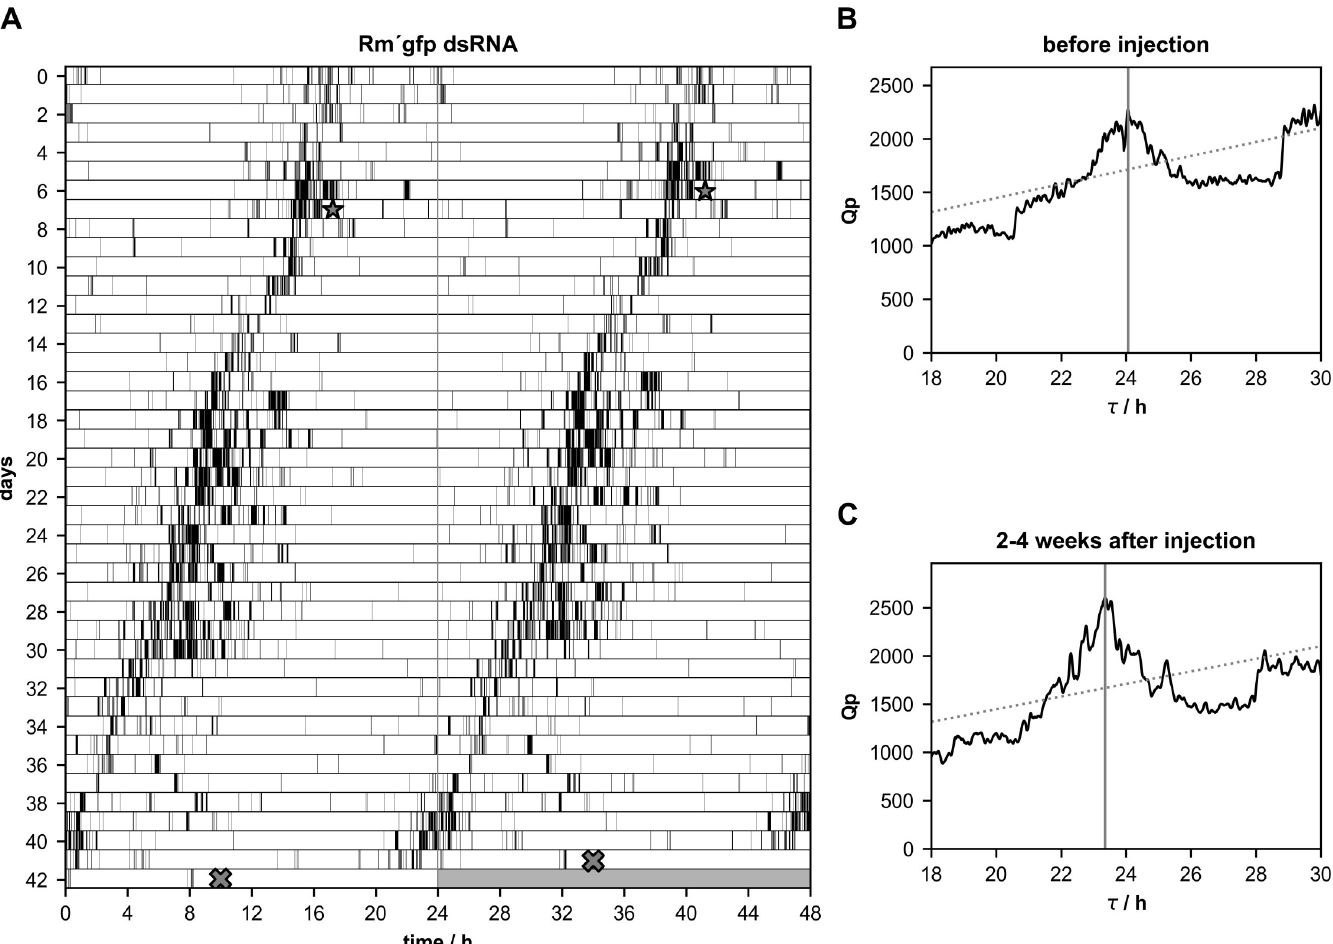
Fig 1. A-C. Control injections of gfp double stranded RNA ( gfp dsRNA) did not change the circadian period( τ ) of rhythmic running wheel activity in Madeira cockroaches (n = 10 of 13). (A) Double-plotted running wheel activity of a Madeira cockroach in constant darkness revealed only small, random changes in its period during the course of the 42 days long recording. An example plot (total n = 13) is shown. At day 7 (star) gfp dsRNA was injected, the animal was sacrificed at day 42 (cross). Chi-square periodogram analysis of the number of running wheel turns indicated significant rhythmicity with a period of 24.07 h 1–7 days before gfp dsRNA injection (B) and 23.35 h 2–4 weeks after the injection (C)